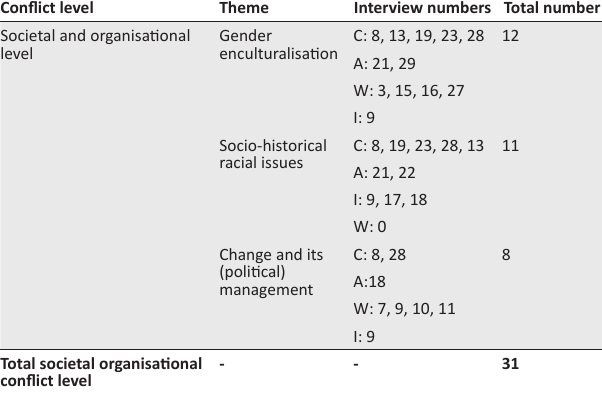
TABLE 3: Conflict on societal and organisational level of women leaders. Conflict level